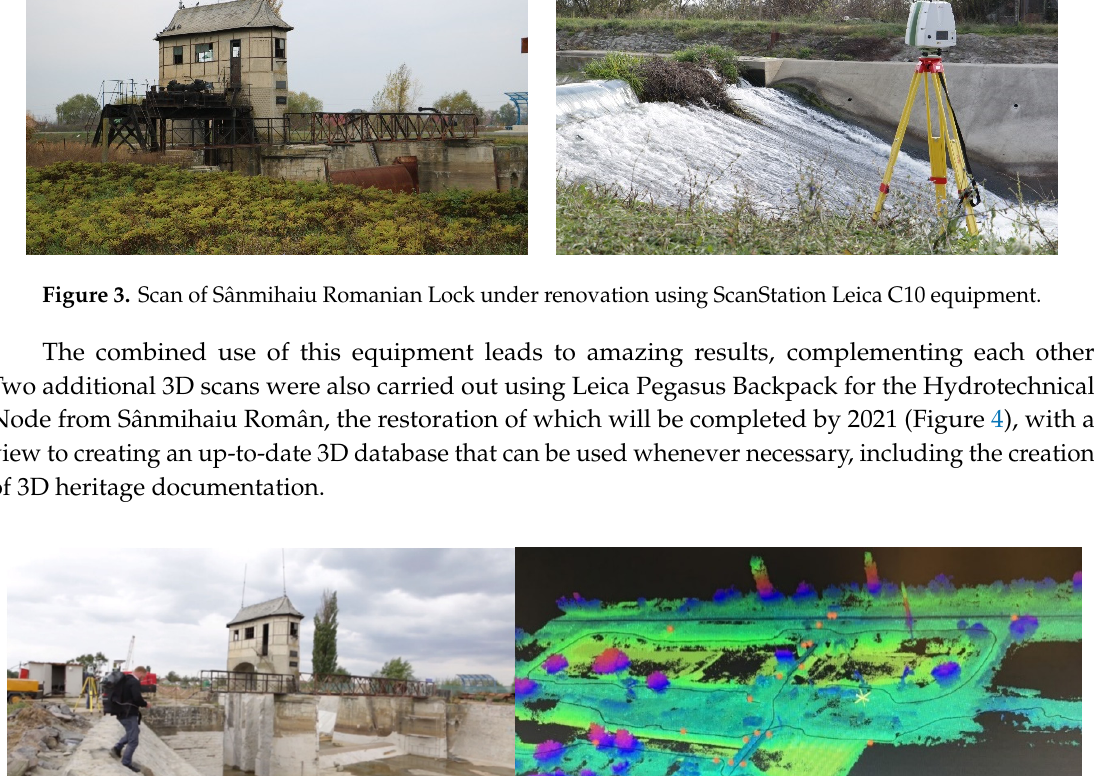
Figure 4. Scanning of the Sânmihaiu Romanian Hydrotechnical Node under renovation using Leica Pegasus Backpack